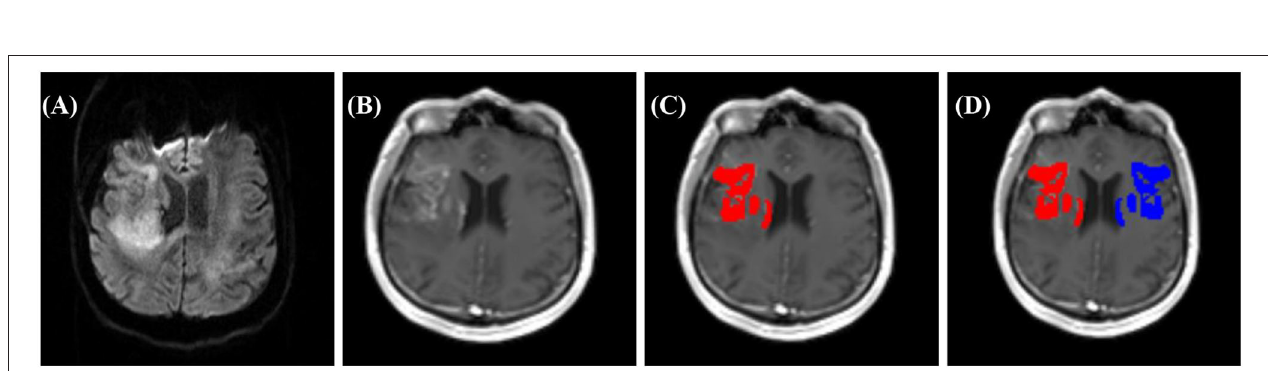
FIGURE 1 | Study flow chart. a Exclusion criteria for BAPTISe study are listed in Supplementary Table 1 . b Exclusions due to complex post-processing steps.